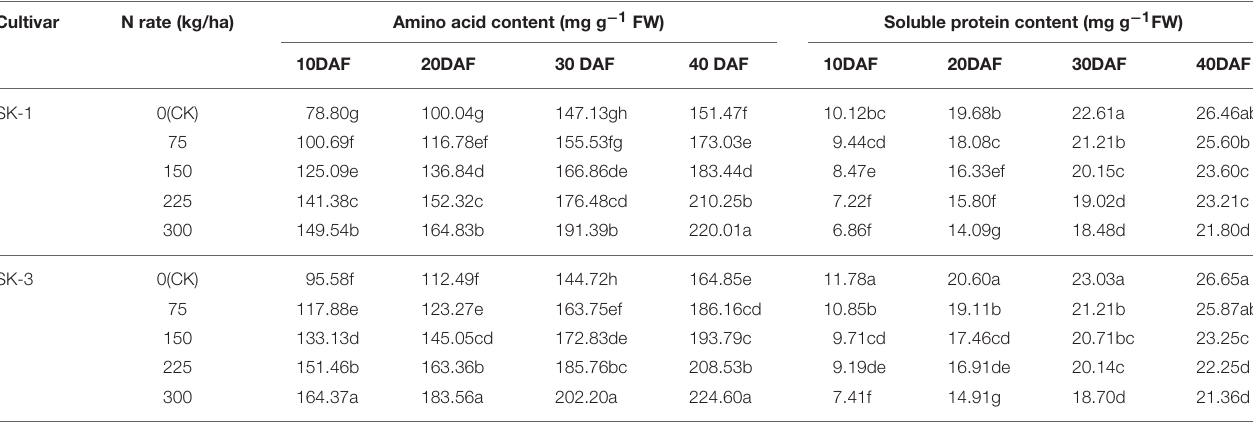
TABLE 6 | The effect of the nitrogen level on the boll shell amino acid and soluble protein content of the two Bt cotton cultivars in 2016. Cultivar